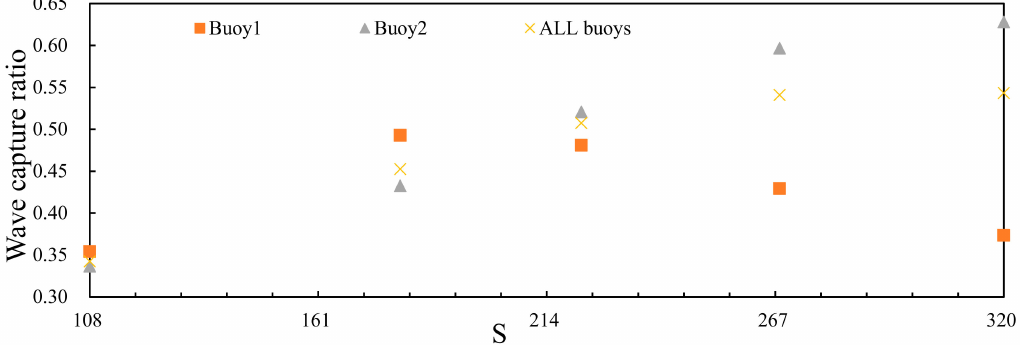
Figure 13. Curve of capture width ratio with